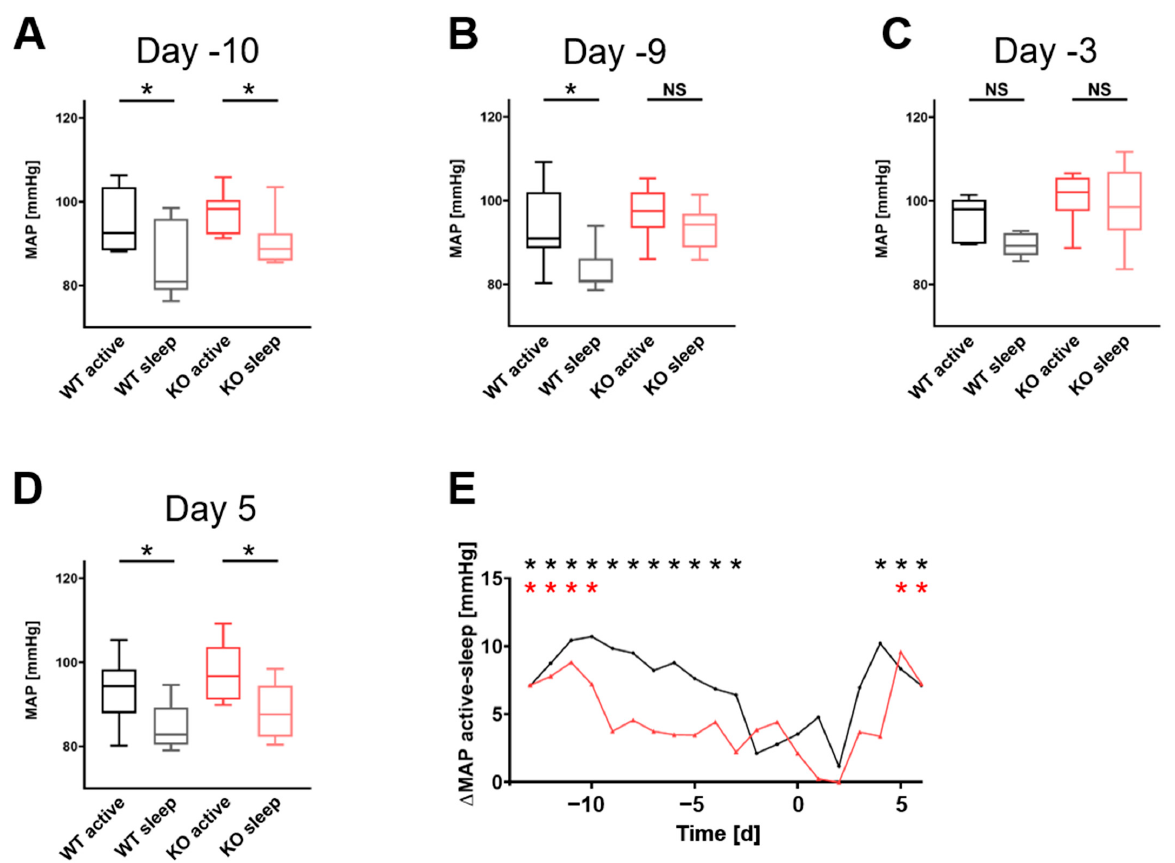
Figure 2. Blood pressure dipping: ( A – D ) are dipping plots at days − 10, − 9, − 3, and +5. The LG9KO animals (red) lose the dipping at day − 9, and it returns at day 5, while the WT animals (black) lose the dipping at day − 3, returning on day 3 (Supplementary Figure S2). ( E ) ∆ MAP of MAPactive– MAPsleep from day − 13 to day 6. LG9KO animals (red) lose their dipping much earlier than the WT animals (black). * statistically significant dipping (passive vs. active), p < 0.05. NS, not